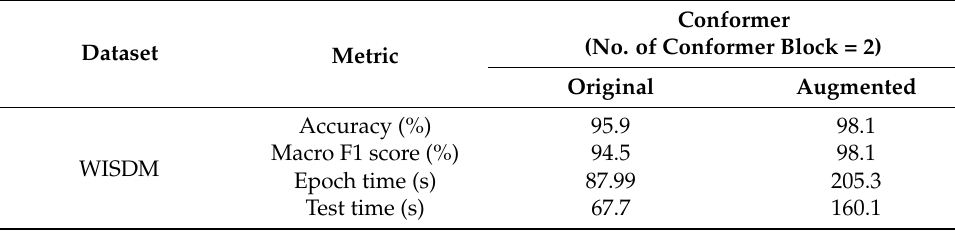
Table 3. Performance of the conformer-based-model when the number of blocks is 2.